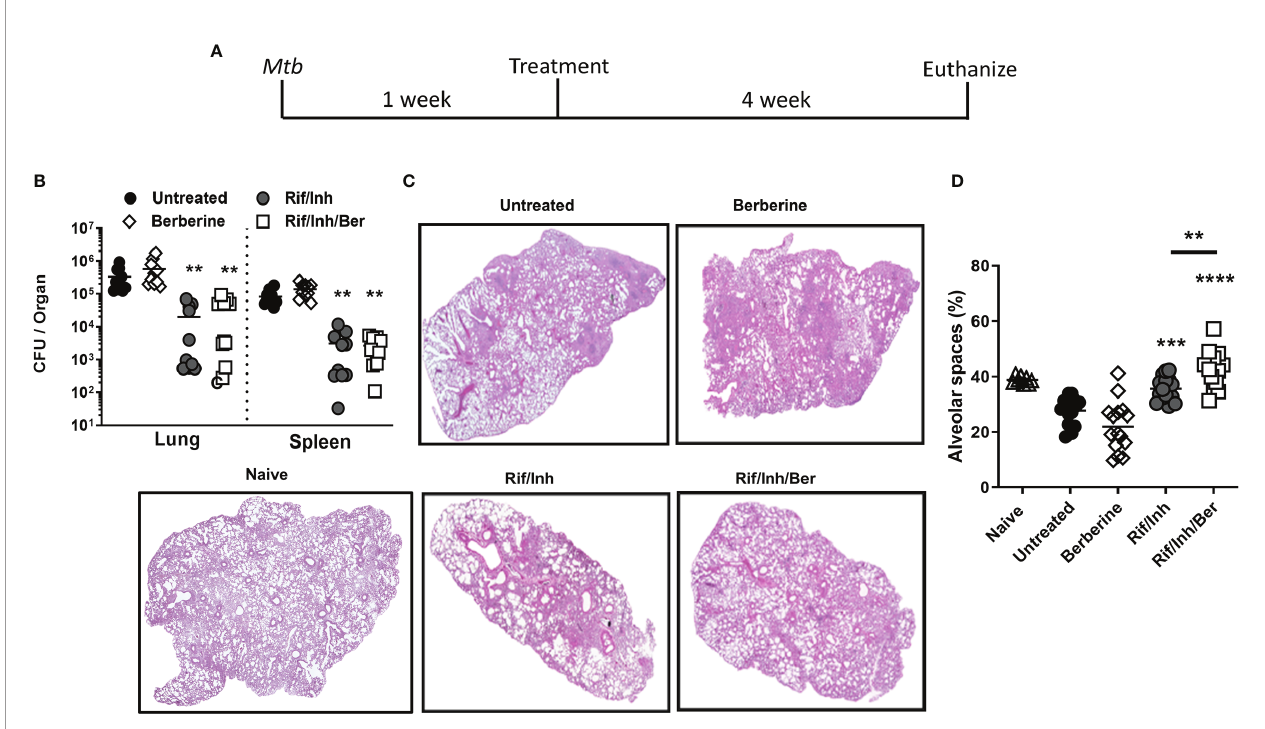
FIGURE 3 | Berberine as an adjunctive therapy against Mtb infection in C57BL/6 mice. (A) Animals were infected with Mtb (100CFU) via aerosol inhalation. After 1 week of infection, mice were either left untreated or treated with berberine (1 mg/ml) or rifampin/isoniazid (0.1 mg/ml) and rifampin/isoniazid in combination with berberine in drinking water for 4 weeks as shown in the layout. (B) Mycobacterial burdens in the lung and spleen. (C) Representative lung section for pathology. (D) Quanti fi cation of free alveolar air spaces in the lungs at 5 weeks post-infection. Data is shown from pooled two experiments (n=10 per group) and the line denotes mean value, analysed by one-way ANOVA with Tukey post-hoc test de fi ning differences in all groups as signi fi cant **P ≤ 0.01; ***P ≤ 0.001; ****P ≤ 0.0001. Asterisks without the line show the signi fi cance compared to the untreated